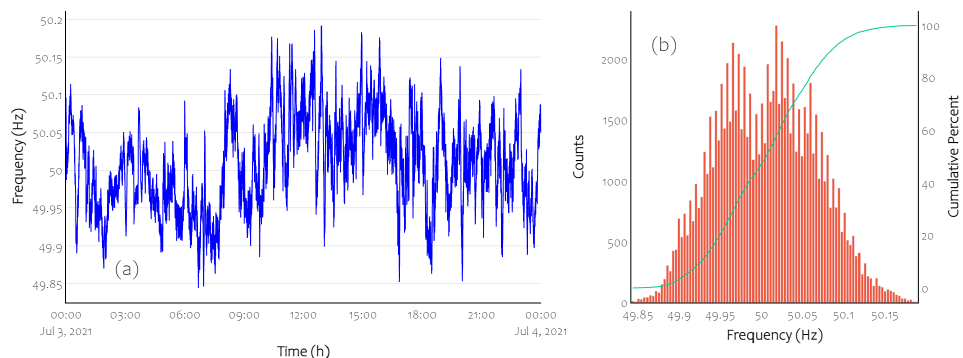
Figure 6. ( a ) Time series data of 24-h of GB weekend system frequency signal used for testing. ( b ) Histogram of frequency signal.